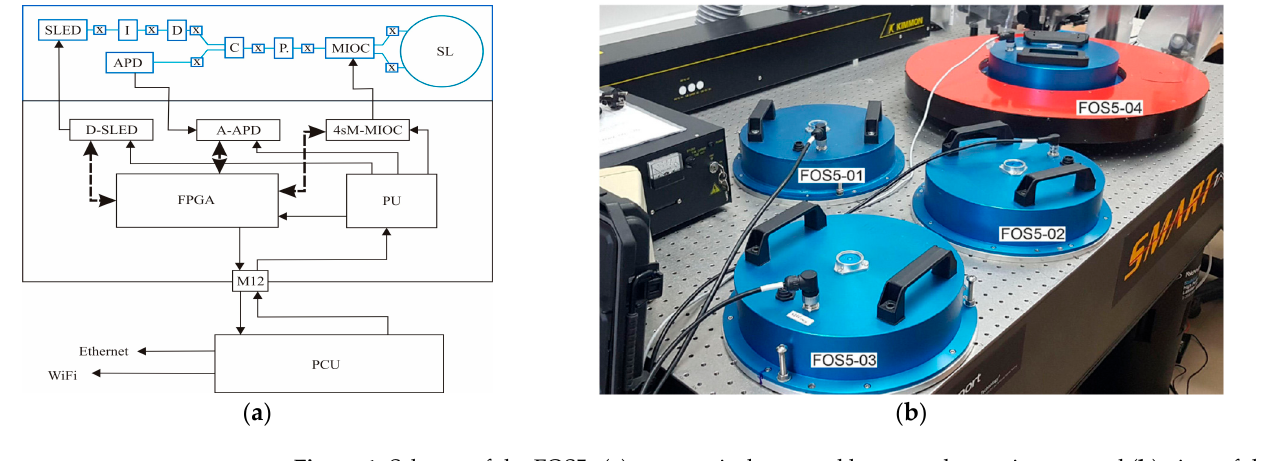
Figure 1. Scheme of the FOS5s ( a ): top–optical part and bottom–electronic part, and ( b ) view of the FOS5-01, . . ., FOS5-04 in the laboratory of the Military University of Technology, Poland [37]. A different SL size has direct influence on the sensor’s sensitivity. For the FOS5- 01, -02, and -03, total transmission losses are in the range of 19.20–21.60 dB, given a √ theoretical sensitivity of about 6.82 × 10 − 8 rad/(s Hz), whereas the FOS5-04 with an √ optical loss of 17.41 dB has a theoretical sensitivity of about 1.14 × 10 − 8 rad/(s Hz) which is approximately 6 times